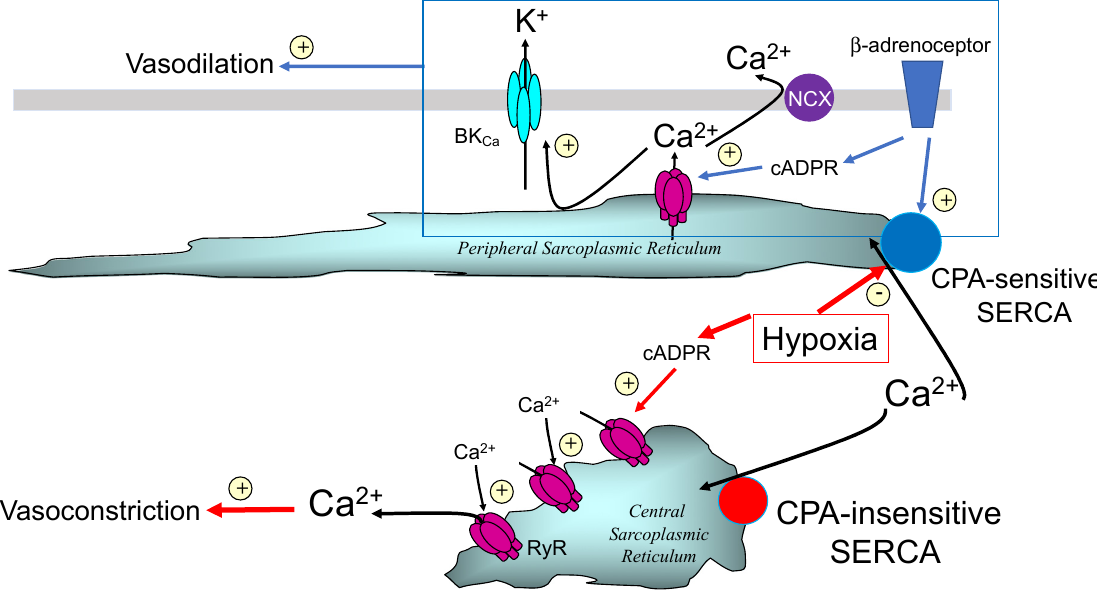
Figure 7. Schematic representation of an early two compartment model developed to explain the curious pharmacology of 8-bromo-cADPR and cyclopiazonic acid.